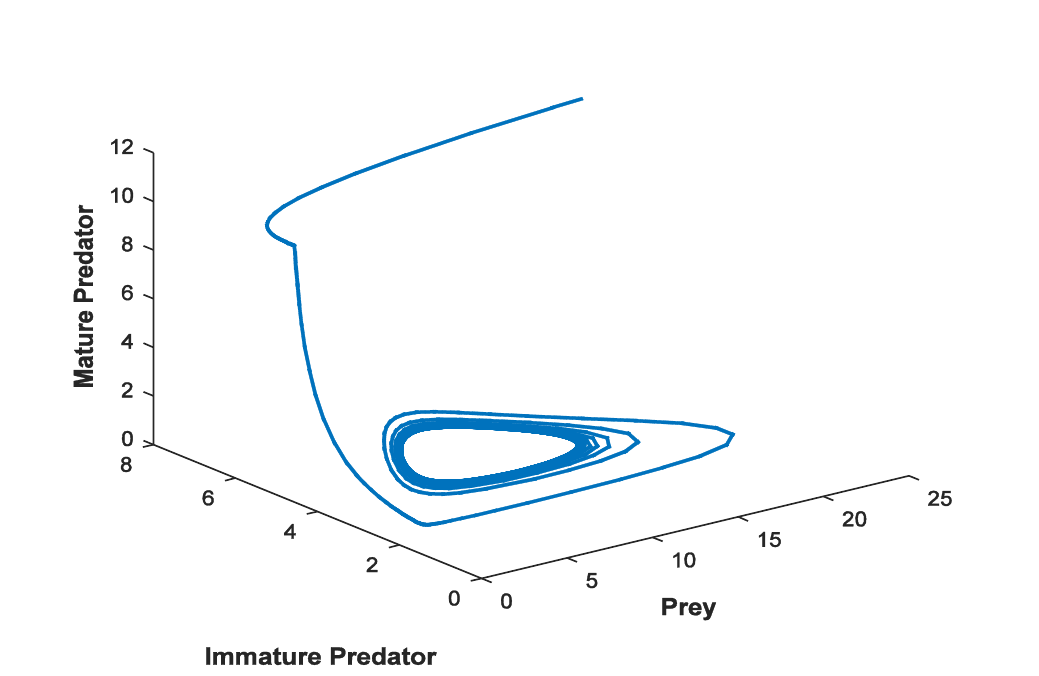
Figure 8. Phase portrait for T=2.7.